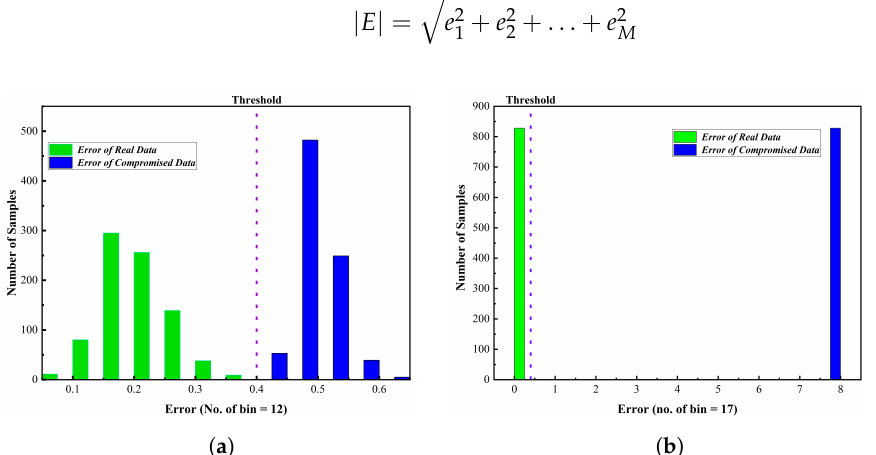
Figure 5. Error distribution : ( a ) for strongest attack vector ( b ) for weakest attack vector.